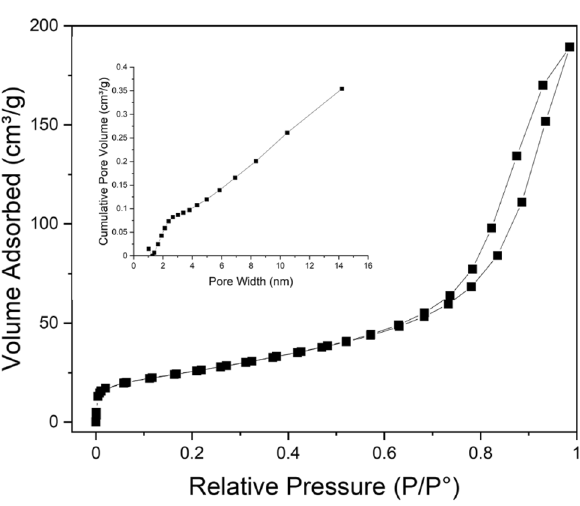
Figure 3. ( a,b ) Bright-field TEM image, ( c ) lattice structure of nano CuO flakes with electron diffraction pattern.